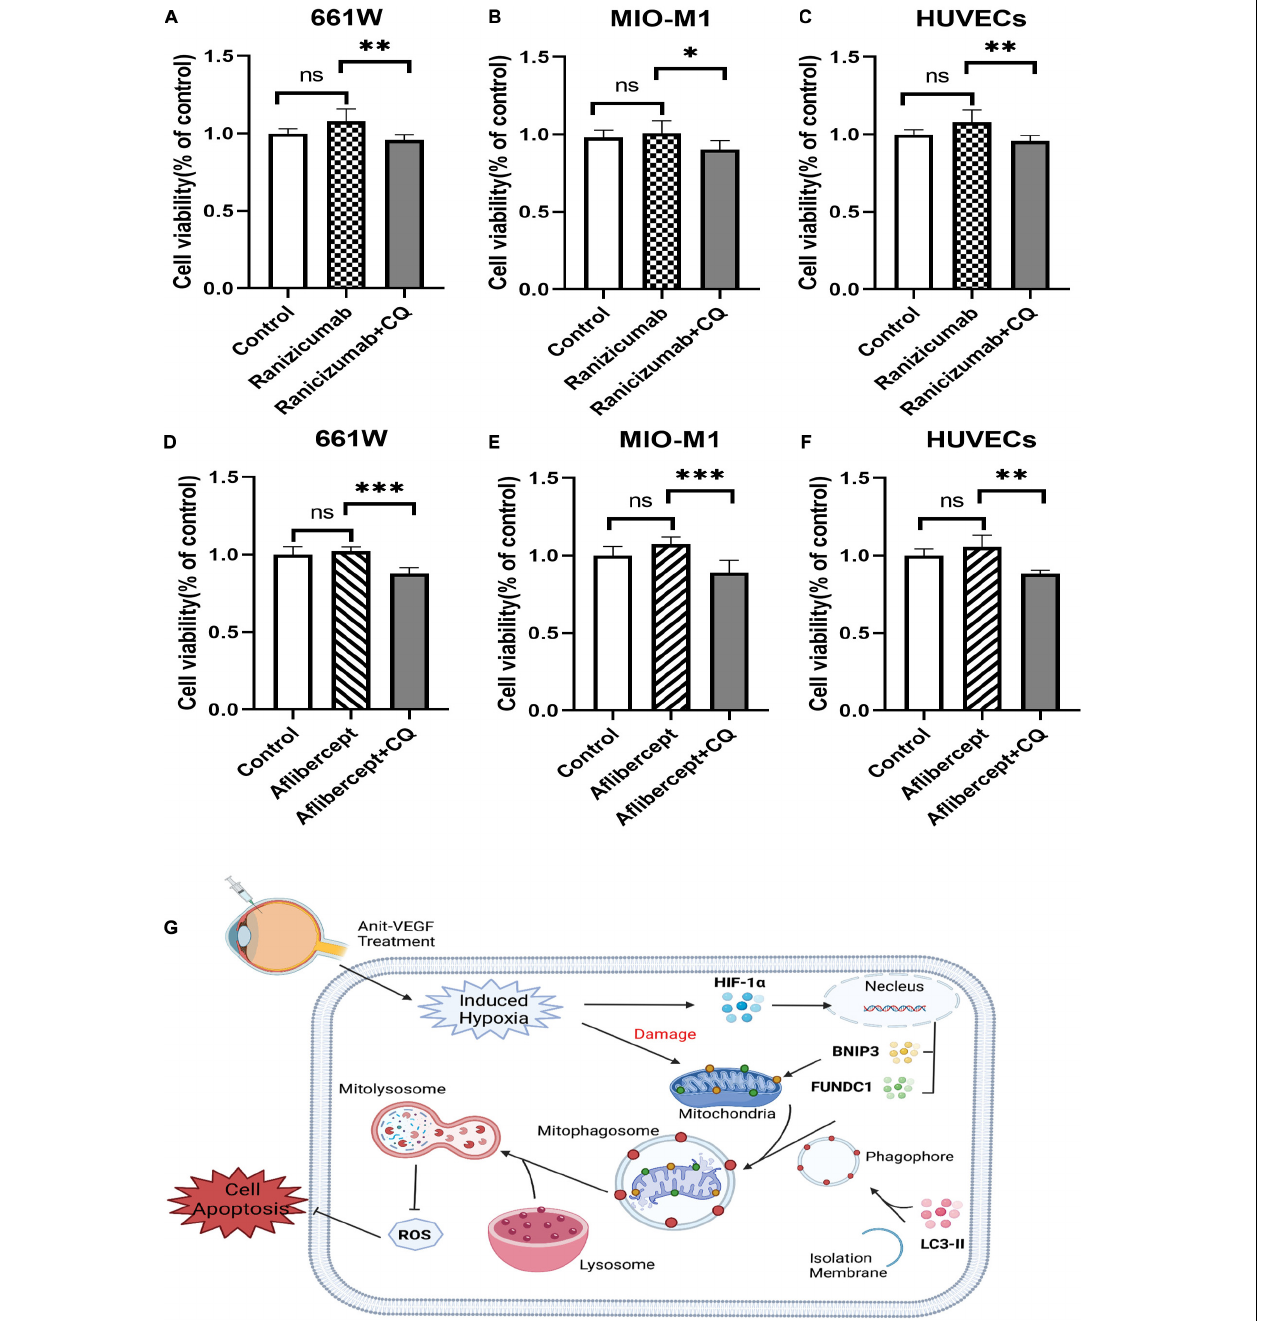
FIGURE 7 | Ranibizumab and aflibercept had same effects with bevacizumab on cell viability in cells of retina. 661W photoreceptors, MIO-M1 Müller cells, and HUVECs were treated with ranibizumab and aflibercept alone or in combination with CQ. (A–F) Cell viability was analyzed by CCK-8 assay. (G) Schematic diagram illustrating that anti-VEGF treatment can exacerbate hypoxia but also induce HIF-1 α /cBNIP3/FUNDC1-mediated mitophagy to reduce ROS production and apoptosis, thereby maintaining cell viability. ns: no significance, * P < 0.05, ** P < 0.01, *** P < 0.001.